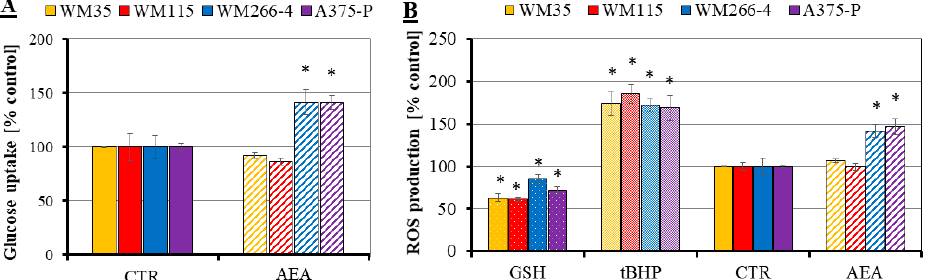
Figure 2. Influence of AEA on melanoma cell metabolism: measurements of the glucose uptake ( A ) and quantification of ROS production ( B ). The investigated cell lines are from the following stages of melanoma progression: RGP site (WM35—yellow), VGP site (WM115—red), metastasis to the lymph node (WM266-4—blue) and from the solid tumor site (A375-P—violet). Two additional controls were prepared: a positive control—cells treated with 100 µ M tBHP and a negative control— cells treated with 5 mM GSH. The statistical significance of the p -value below 0.05 (*) was marked on the